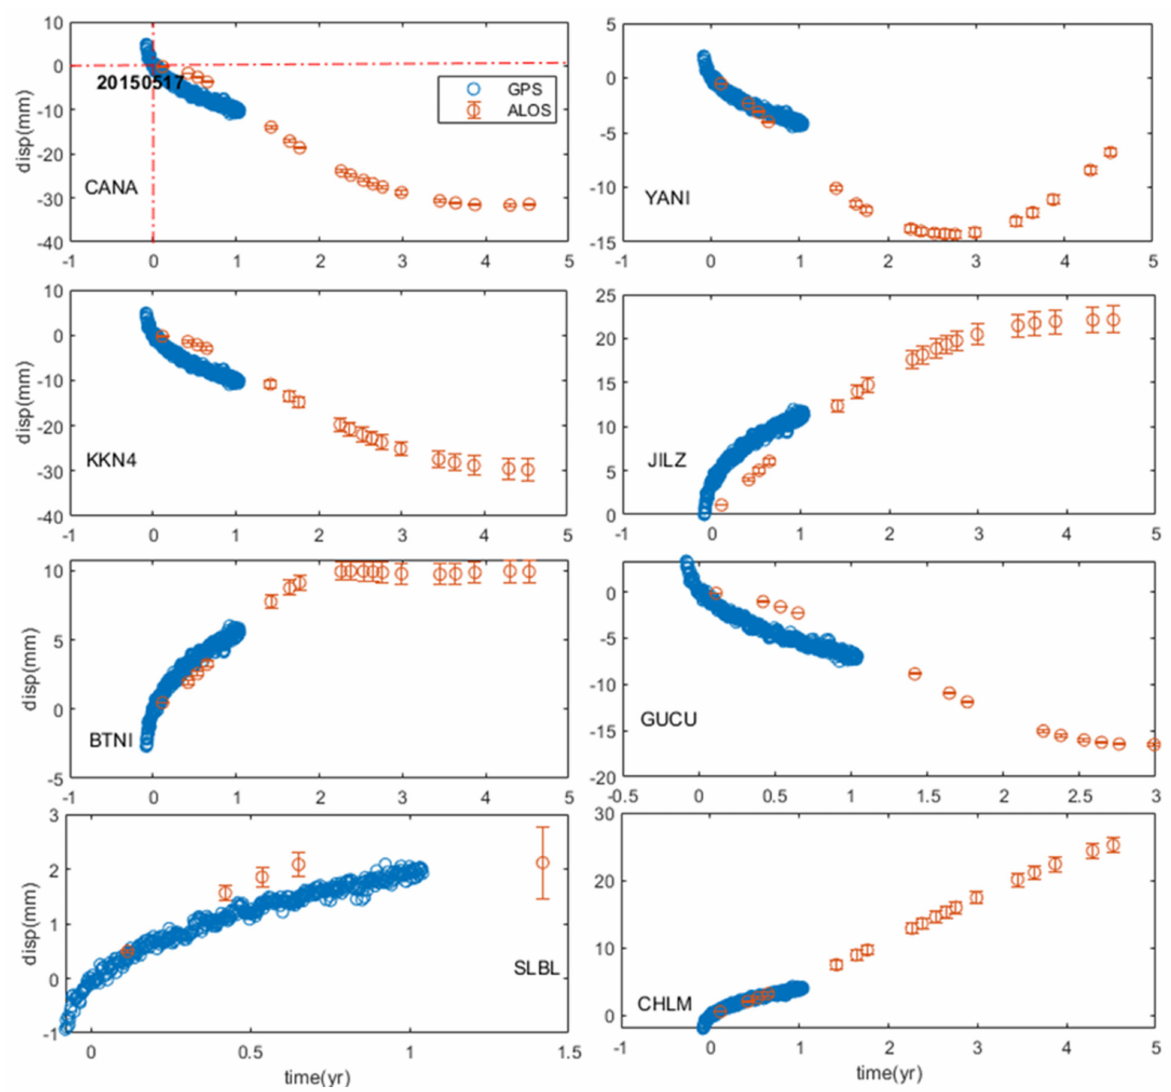
Figure 9. Comparison of displacement of ALOS-2 and GPS measurements, started in 17 May 2015. The blue circle represents the GPS time series data; the orange circle represents the ALOS-2 data; the error bar indicates the standard deviation of 64 adjacent pixels; the GPS data is projected onto the LOS